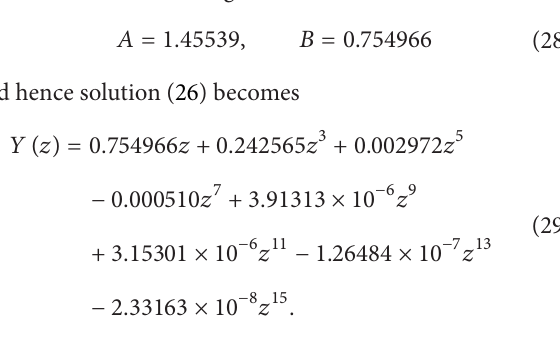
Figure 4: Velocity profile for different values of slip parameter and Reynold and Hartmann numbers with Re < Me.